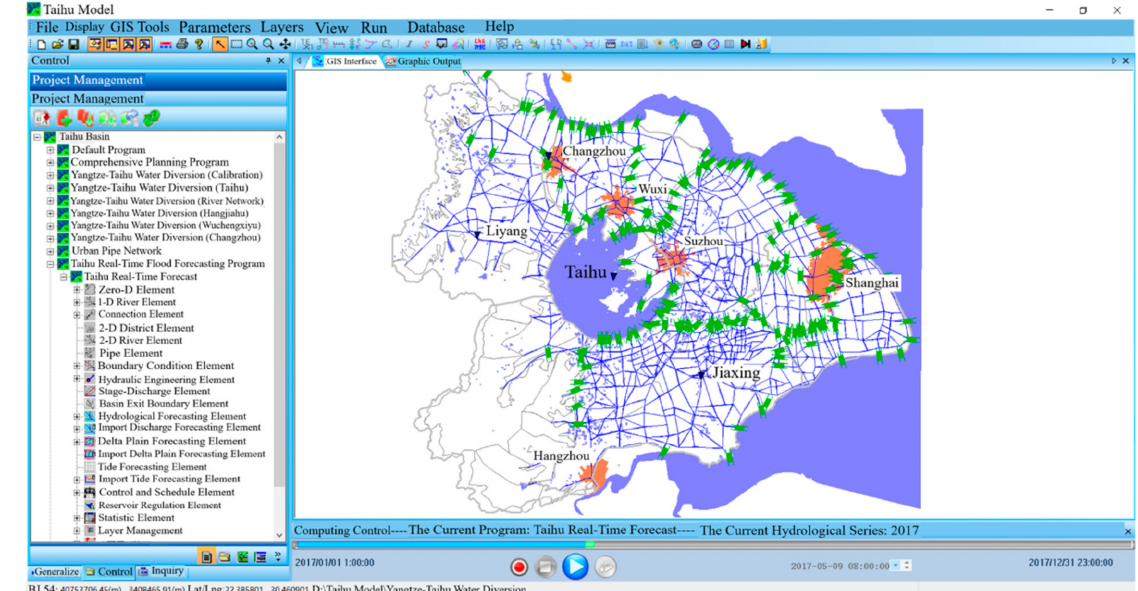
Figure 6. The interface of the distributed-framework basin modeling